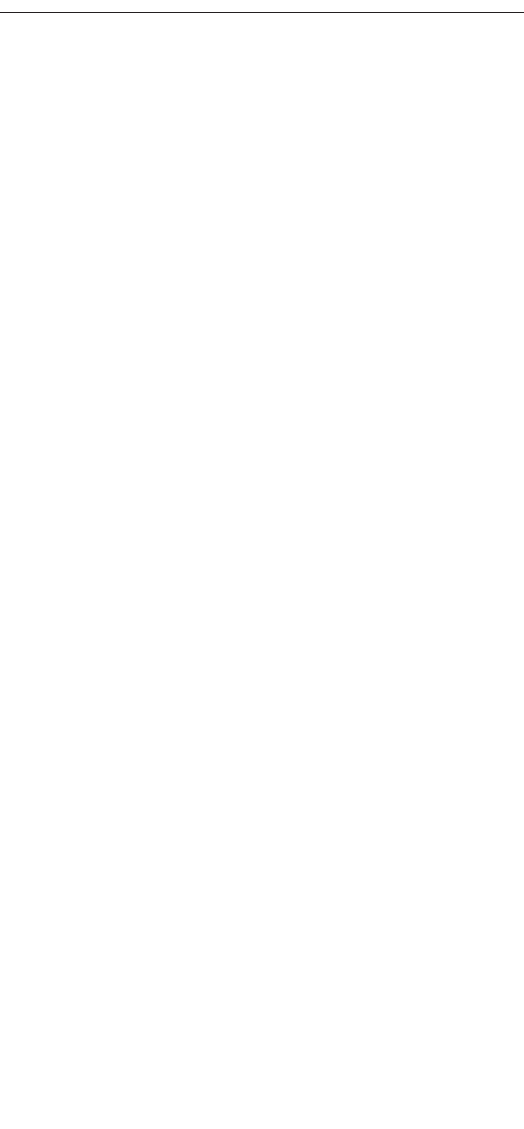
FIGURE A1 | Bisulfite analysis of subtelomeric regions 15q and 16p in WT FSE fibroblast. Bisulfite sequence analysis was carried out for a region in subtelomeres 15q and 16p. The analyzed regions contain 17CpG sites in 15q subtelomere and 11CpG sites in subtelomere 16p. White circles represent unmethylated CpG dinucleotides and black circles represent methylated CpG dinucleotides. Gray circles represent CpG sites that were converted to CpA or TpA, as occasionally can be observed. Each row is derived from an individual subclone. Percent of CpG methylation appears below the cell